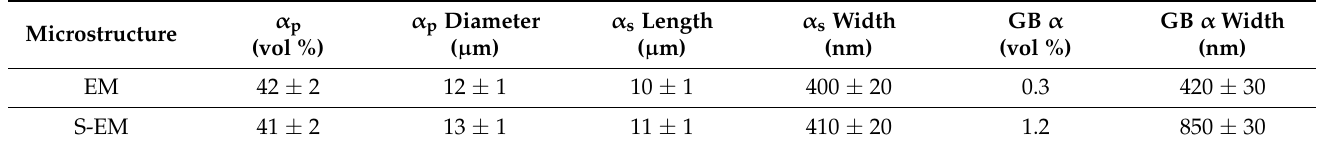
Figure 4. XRD patterns of the TA19 titanium alloy: ( a ) initial microstructure, ( b ) EM, and ( c ) S-EM.